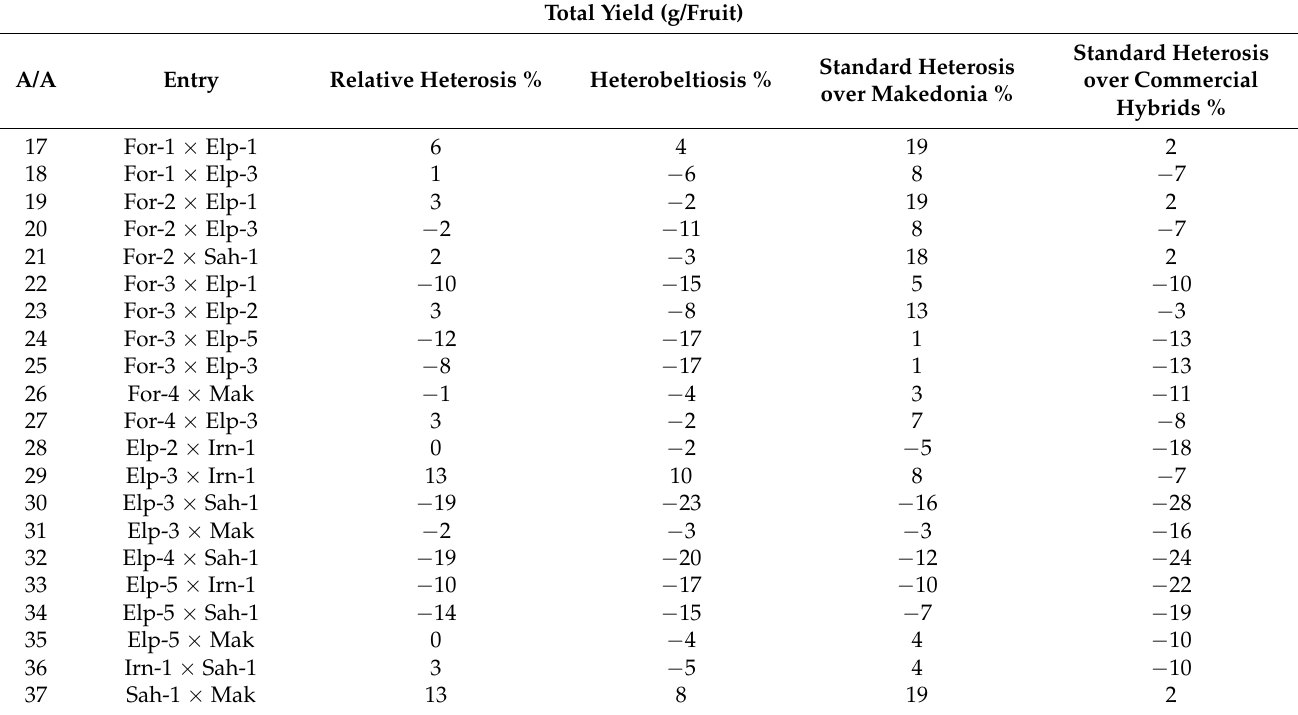
Table 9. Relative heterosis, heterobeltiosis, and standard heterosis of the original commercial hybrids, the new recombinant inbred lines, and the reconstructed new hybrids, as for total yield